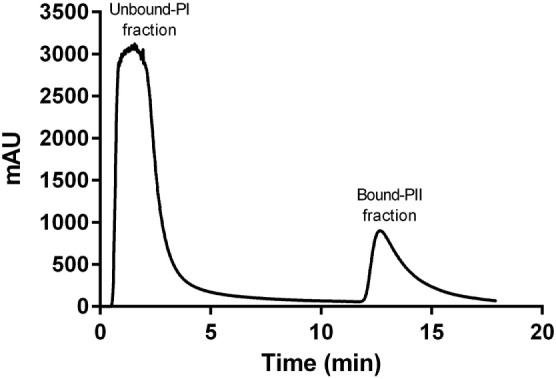
Representative chromatogram of a depleted plasma sample prepared using affinity chromatography on an immobilized Frutalin column attached to an fast protein liquid chromatography system ÄKTApurifier 10 (GE Healthcare). Chromatography was performed at a constant flow of 1 ml/min and absorbance was monitored at 216 nm. The column was washed with a solution of 20 mM Tris–HCl, pH 7.4, 0.15 M NaCl. The non-retained peak (Unbound-PI fraction) was collected, and the bound material (retained peak, Bound-PII fraction) was eluted using d-galactose in a solution of 0.2 M Tris–HCl 20 mM, pH 7 4, 0.15 M NaCl.